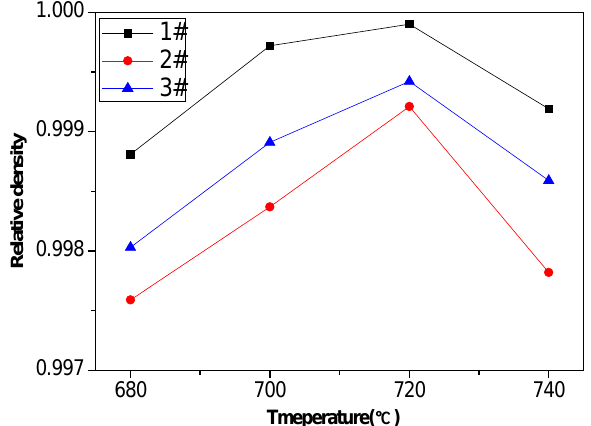
Figure 5. The density result of vacuum counter-pressure casting aluminum alloy sample under different ultrasonic temperature.